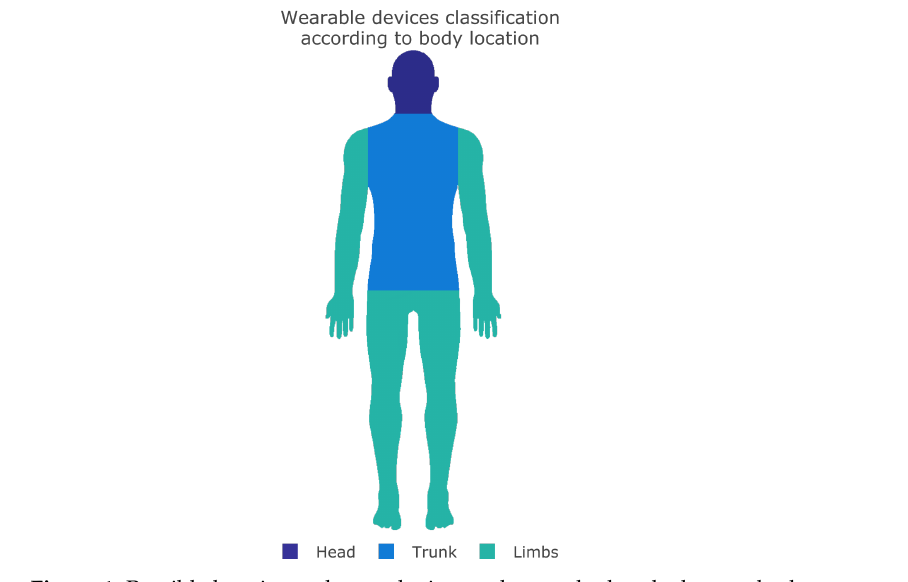
Figure 1. Possible locations where a device can be attached to the human